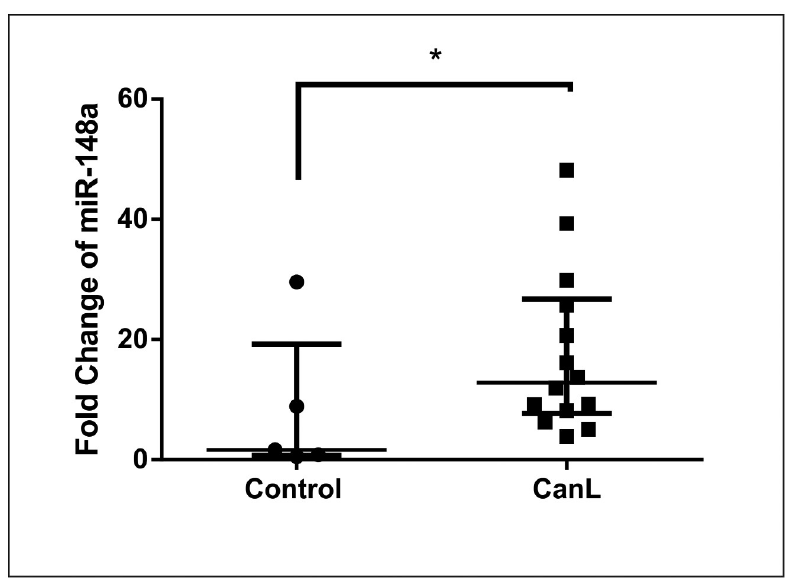
Fig 1. Expression of miR-148a during CanL. miR-148a expression was quantified using real-time PCR in SL of control and CanL groups. Bars represent miR-148a expression median values (1.616 and 12.82), 25 th (0.6716 and 7.701) and 75 th (19.21 and 26.71) percentile interquartile range from control and CanL groups, respectively. Symbols represent data from individual animals. Asterisks represent significant differences (Mann-Whitney test, p = 0.03).